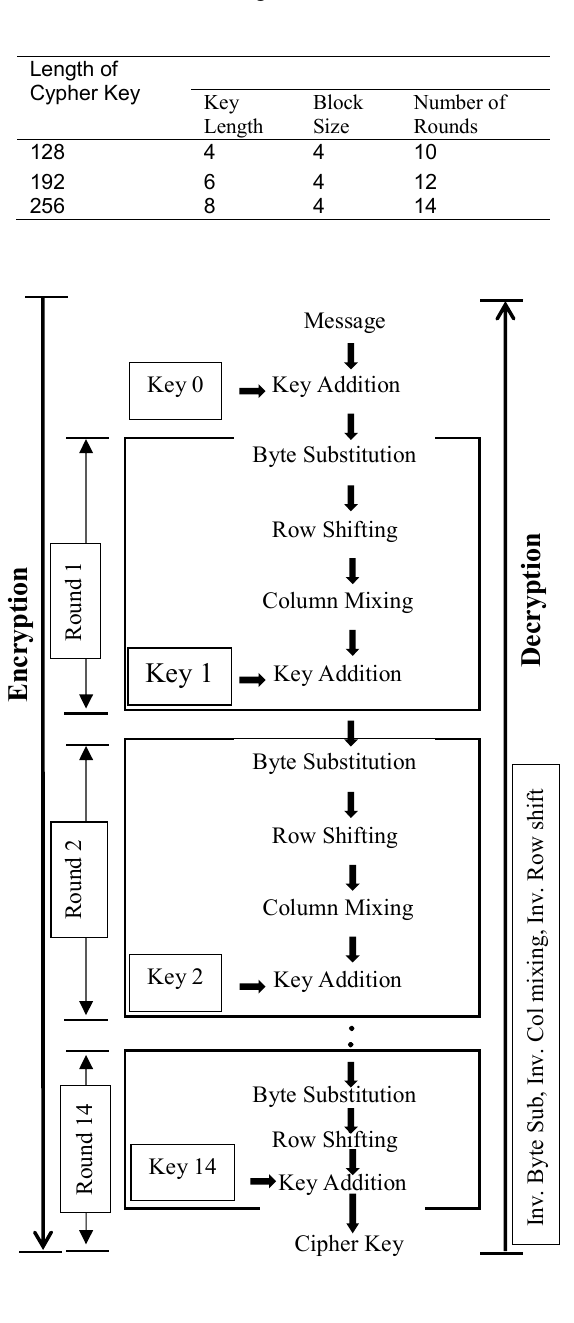
Figure 4 . Structure of an AES Algorithm